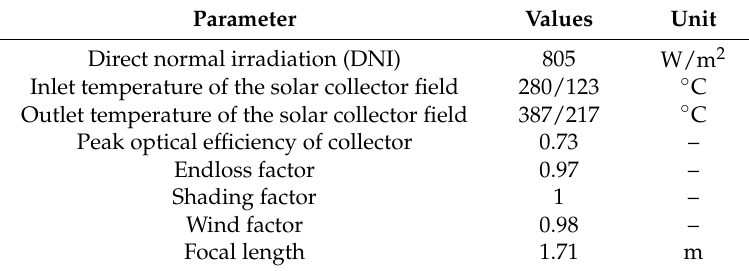
Table 3. Main parameters of the trough solar-collector subsystem.